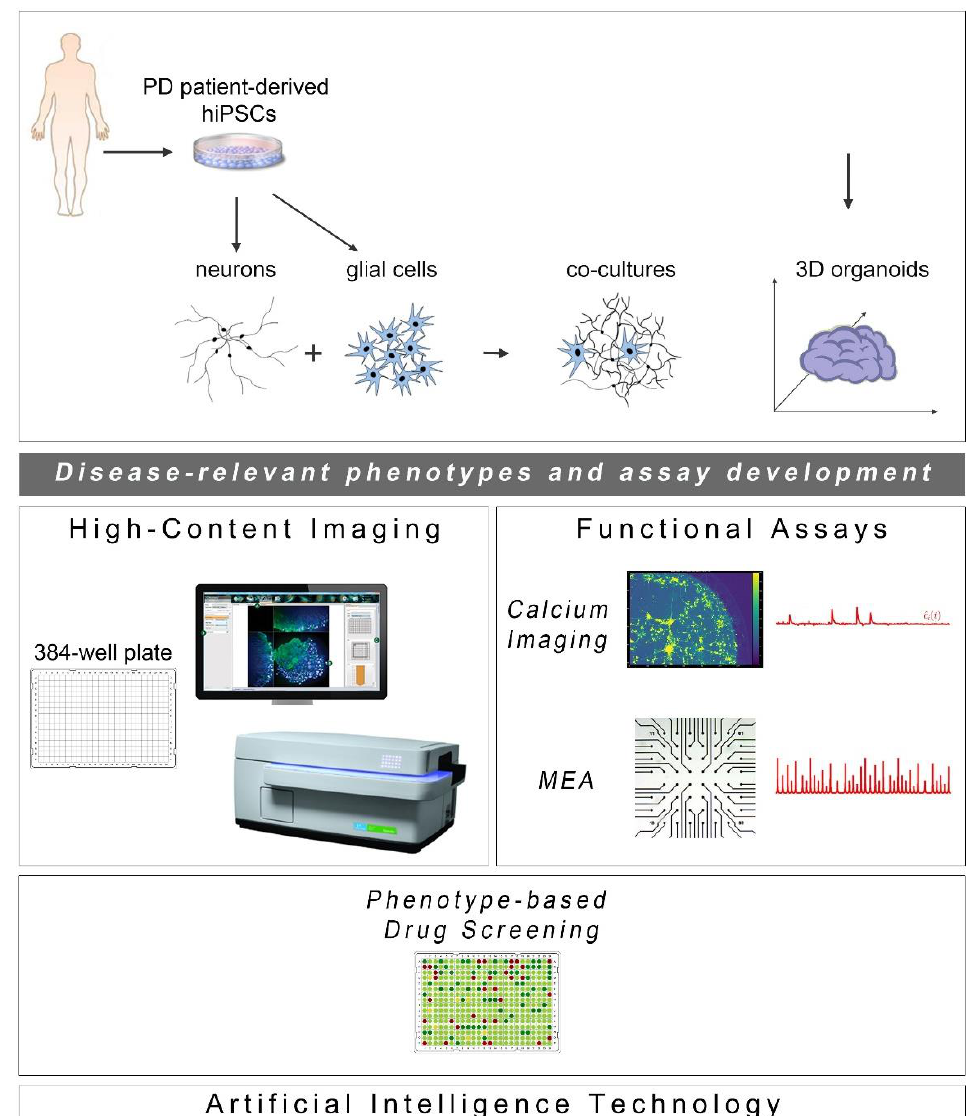
Figure 1. Cell reprogramming technologies allowed the generation of Parkinson’s disease (PD) patient-derived hiPSCs that are further differentiated into neuronal and glial cell populations (astrocytes (shown), but also oligodendrocytes or microglia (not shown)) studied separately or in co-culture with neurons. hiPSC-derived brain organoids are being created to better simulate the human disease. The PD-relevant phenotypes identified in these cellular systems form the foundations for the development of drug discovery platforms encompassing high-content imaging / chemical library screening as well as functional assays, such as calcium imaging and high-resolution multi-electrode array (MEA) recordings (phenotypic drug screening). The application of artificial intelligence technologies will be critical for analysis of the resulting large and complex data sets.